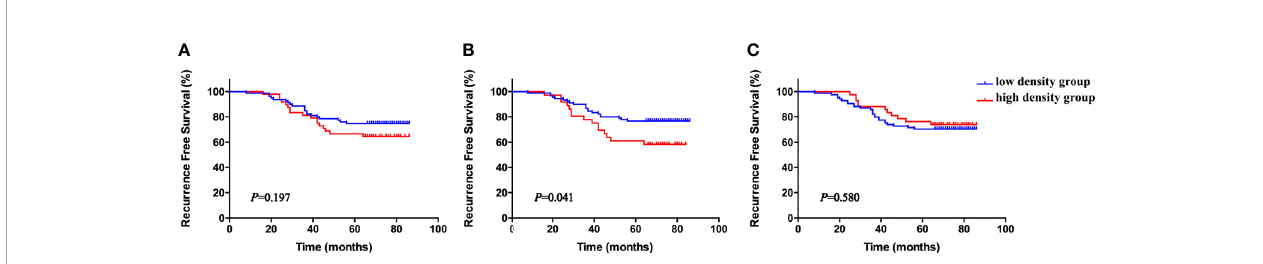
FIGURE 2 | Kaplan – Meier RFS curves according to density of total tissue CD66b + neutrophils (A) , stromal CD66b + neutrophils (B) , and tumor nest CD66b + neutrophils (C) , all strati fi ed by medians. P -values obtained from log-rank tests. RFS, recurrence-free survival.